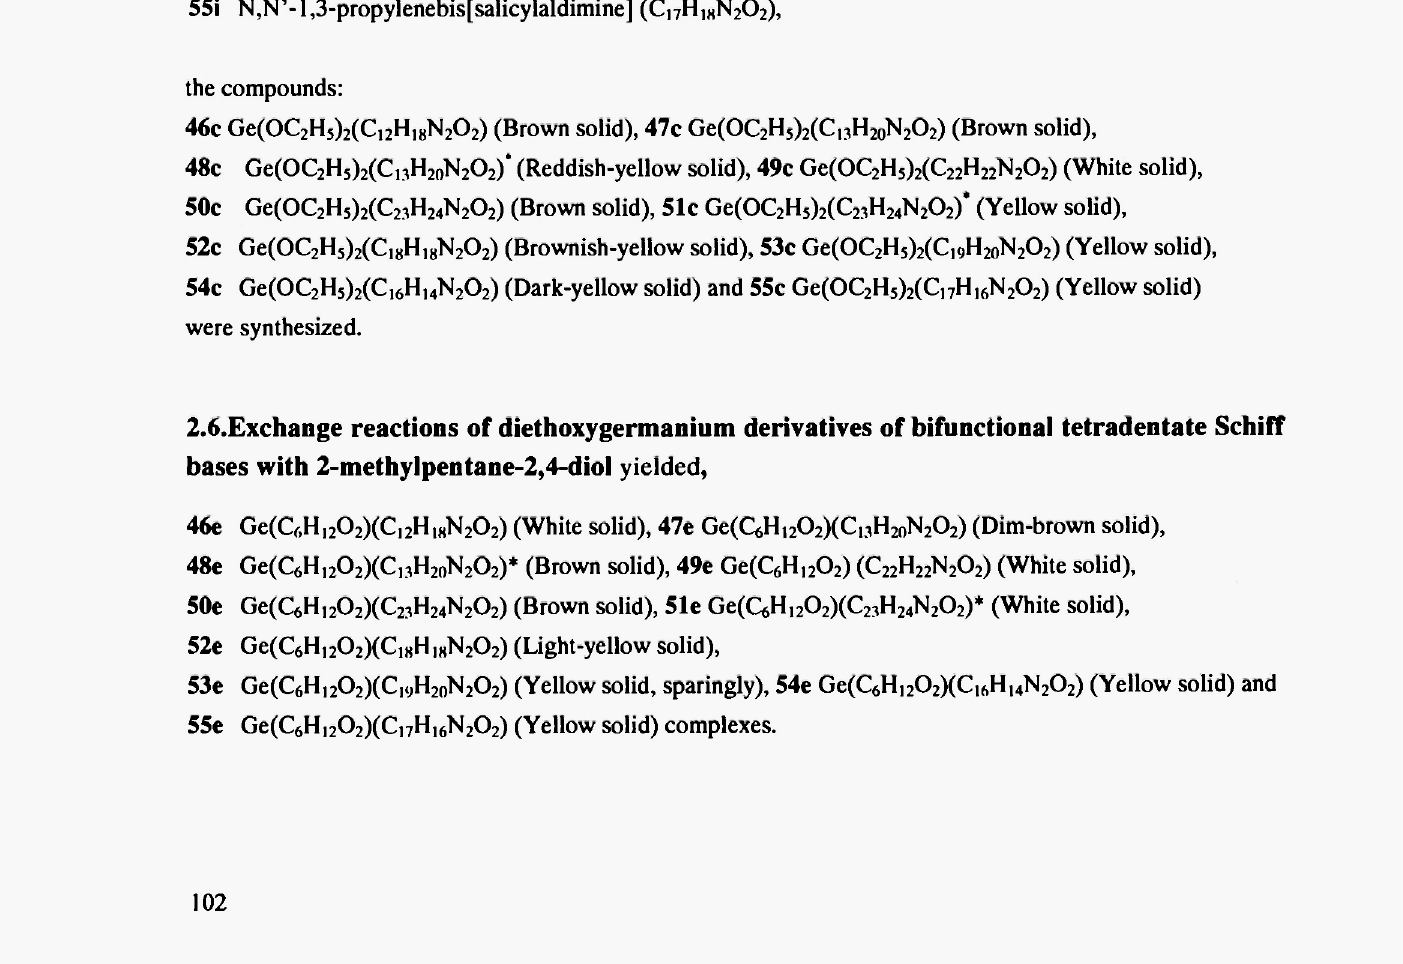
2.6.Exchange reactions of diethoxygermanium derivatives of bifunctional tetradentate Schiff bases with 2-methylpentane-2,4-diol